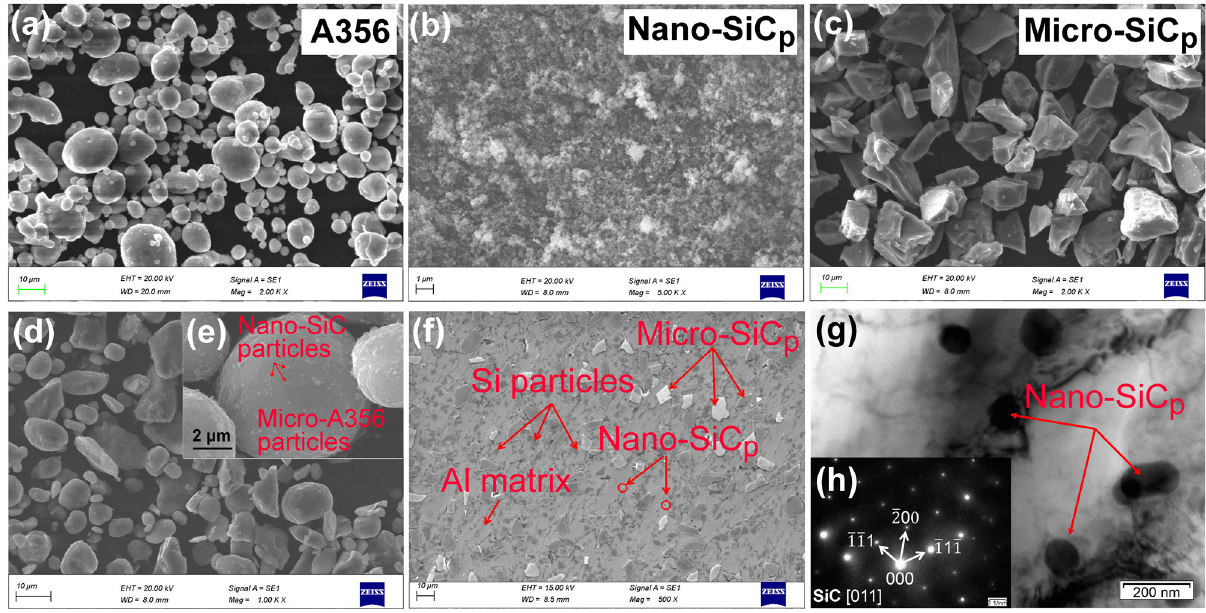
Figure 2: Morphologies of the preparation process of dual - scale SiC p /A356 composites used: ( a ) A356 powders; ( b ) nano - SiC p powders; ( c ) micro - SiC ( d ) mixed powders after ball milling; ( e ) high - magni fi cation image of the mixed powders showing the uniform p powders; distribution of nano - SiC p on the A356 particles; ( f ) SEM images of the composites; ( g ) TEM images of the composites; and ( h ) corre - sponding di ff raction pattern of the nano - SiC p .